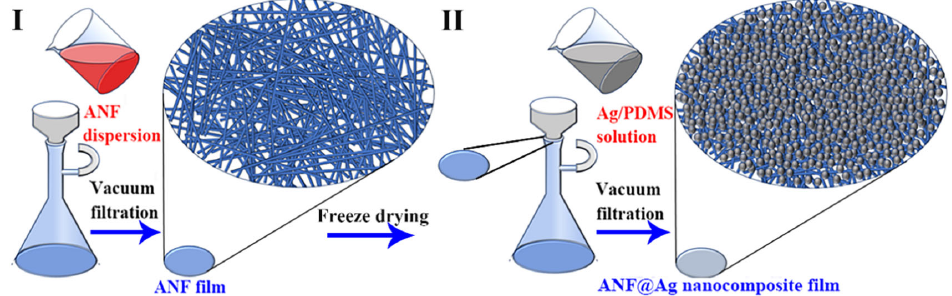
Figure 1. Schematic illustration of the preparation processes of the ANF@Ag nanocomposite film.